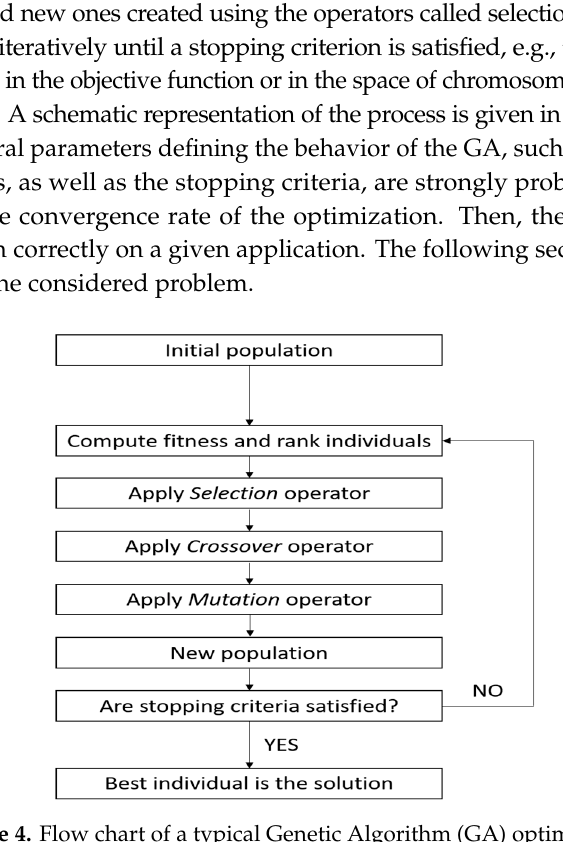
Figure 4. Flow chart of a typical Genetic Algorithm (GA) optimization.